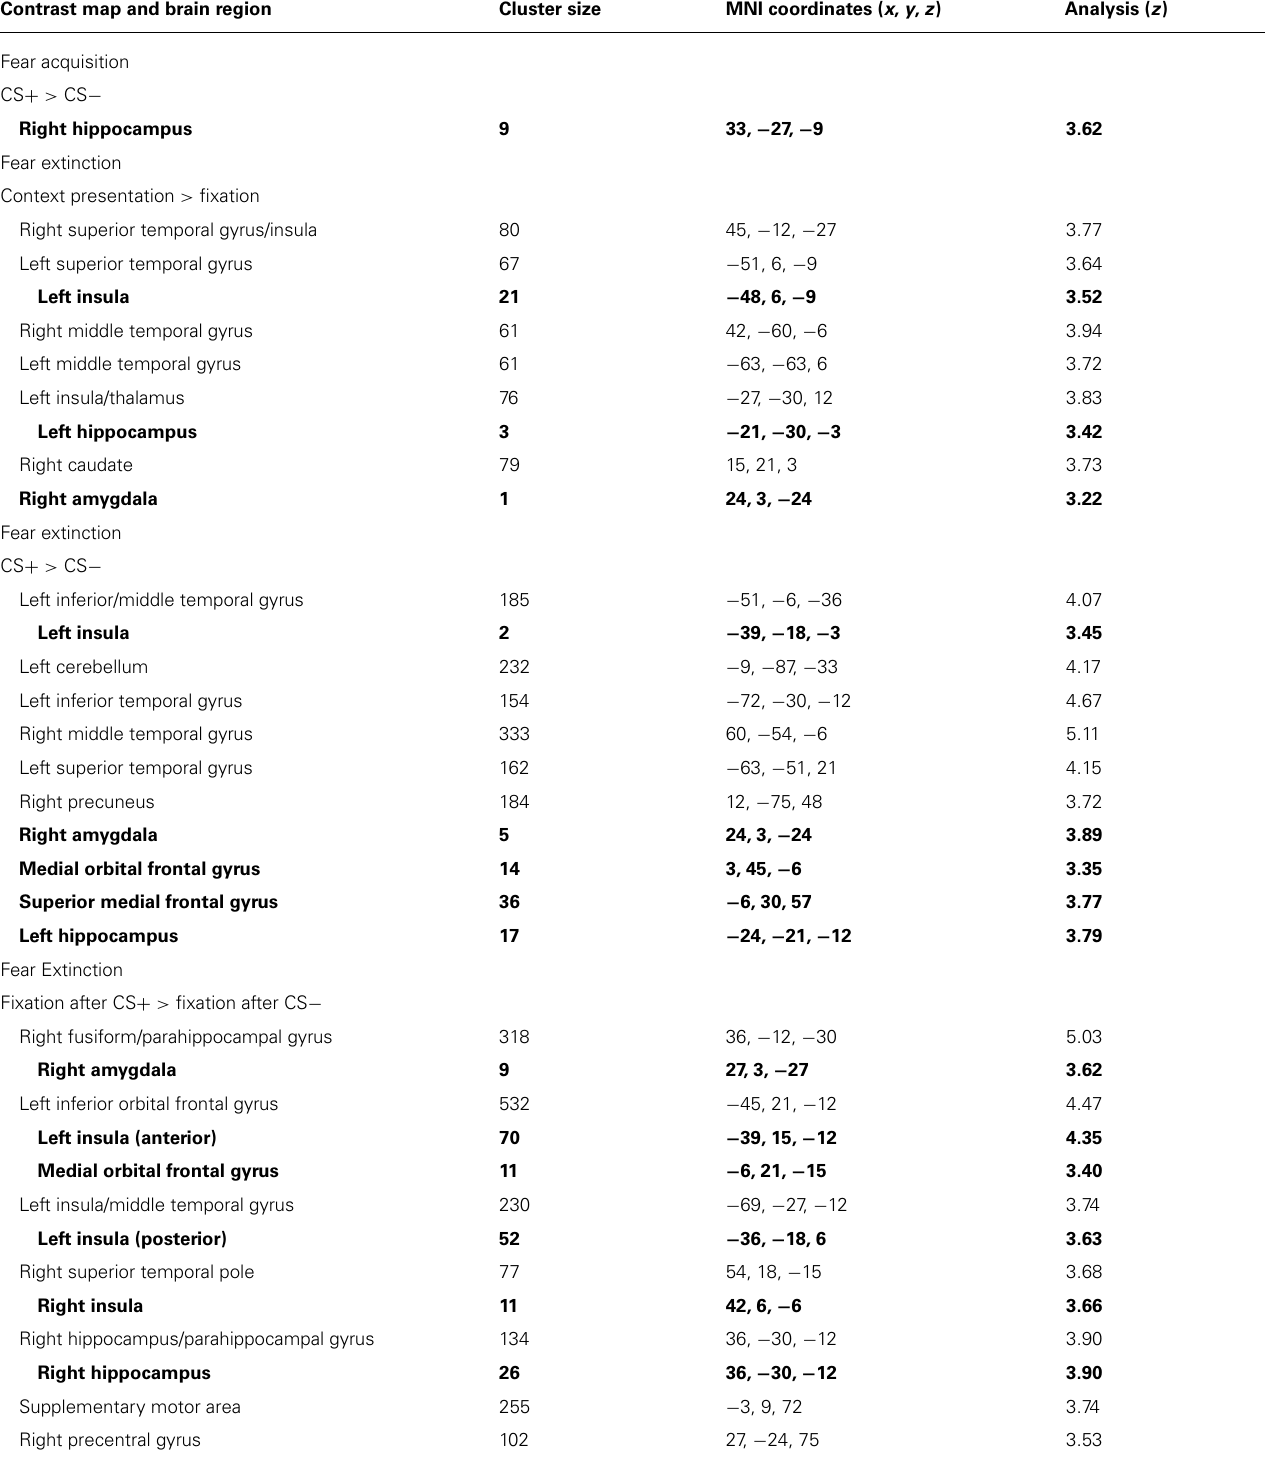
Table 1 | Correlations with CAPS avoidance